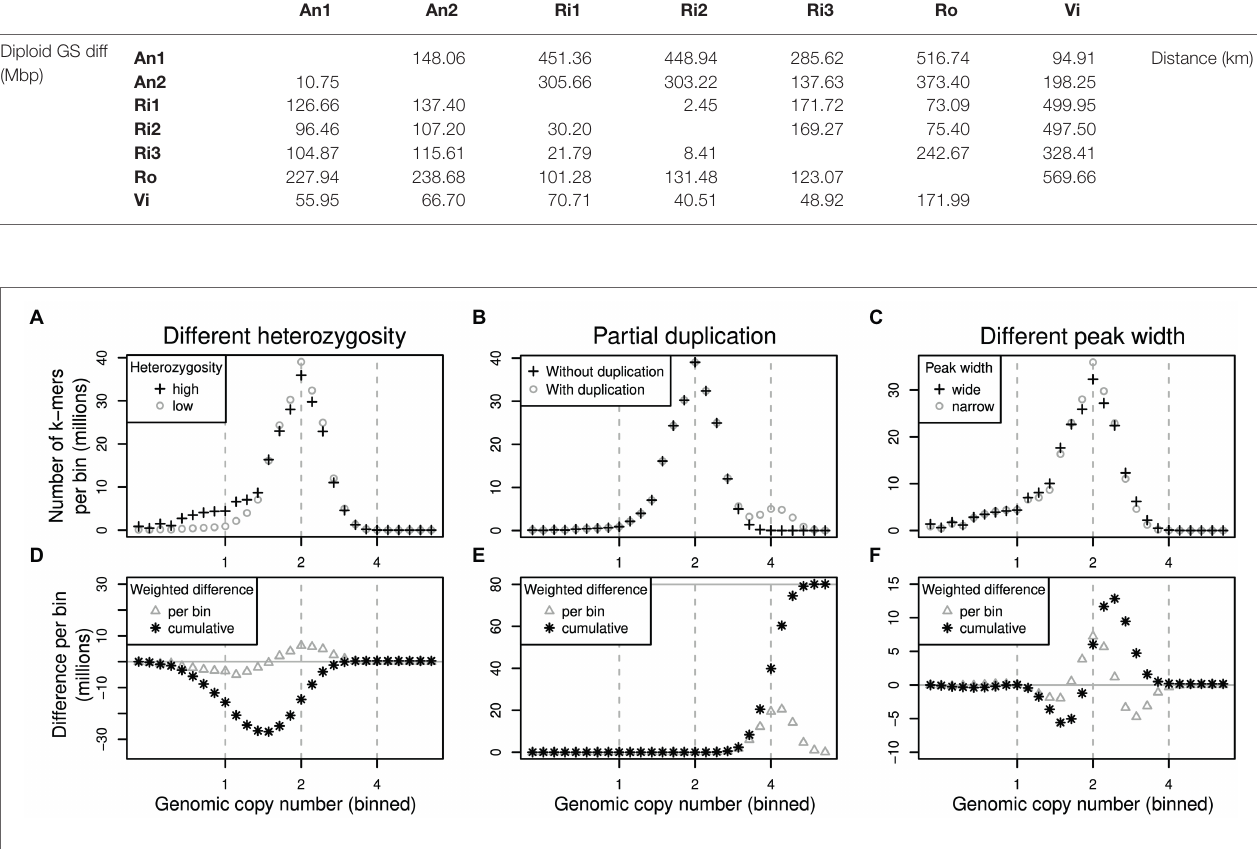
FIGURE 2 | Schematic of pairs of (binned) k-mer spectra (top row) and their corresponding spectrum difference graphs (bottom row). Three different scenarios are shown in columns: (1) two samples of identical genome size with different heterozygosity levels (A,D) , (2) two samples where one contains some additional, duplicated sequence (B,E) and (3) two samples with identical sequences but whose k-mer spectra have different peak widths (C,F) . Refer to main text for detailed